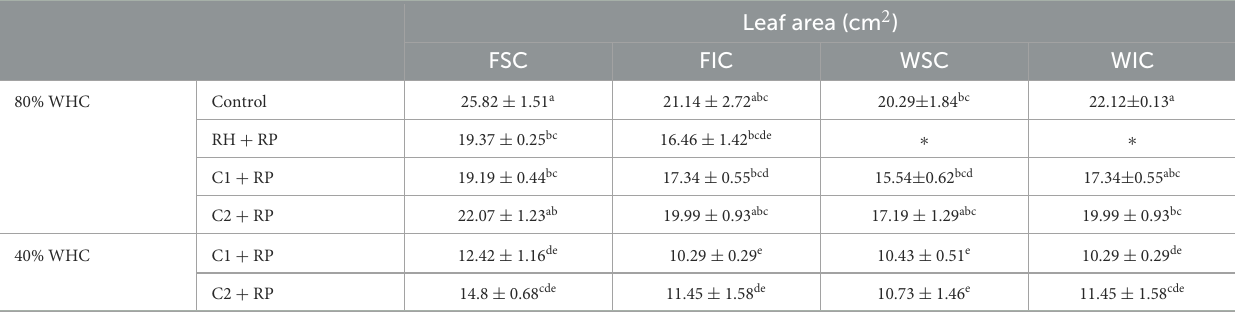
TABLE 2 Leaf area of faba bean and wheat grown as a sole crop or intercropped (FSC, Faba bean sole crop; FIC, faba bean intercropped; WSC, wheat sole crop; WIC, wheat intercropped) under water sufficiency and P limitation (80% WHC, RP) vs. combined water deficit and P limitation (40% WHC, RP) and inoculated with two rhizobacterial consortia (C1 and C2) containing rhizobia and two